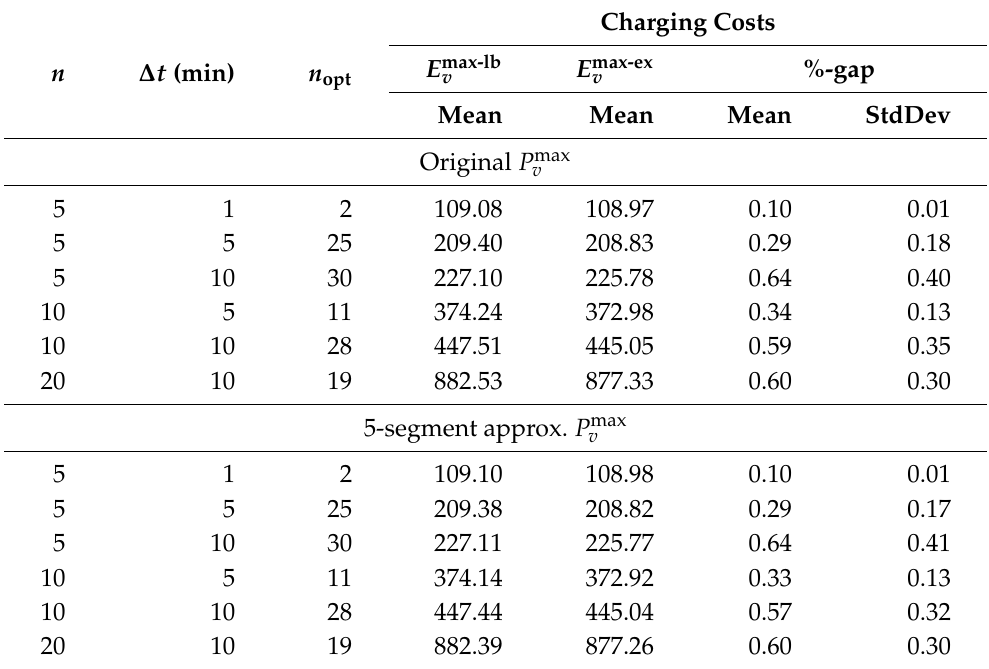
Table 7. Objective value comparison using EVS-SOC-GLIN and different E max v functions based on the five-segment P max v approximation and the original P max v